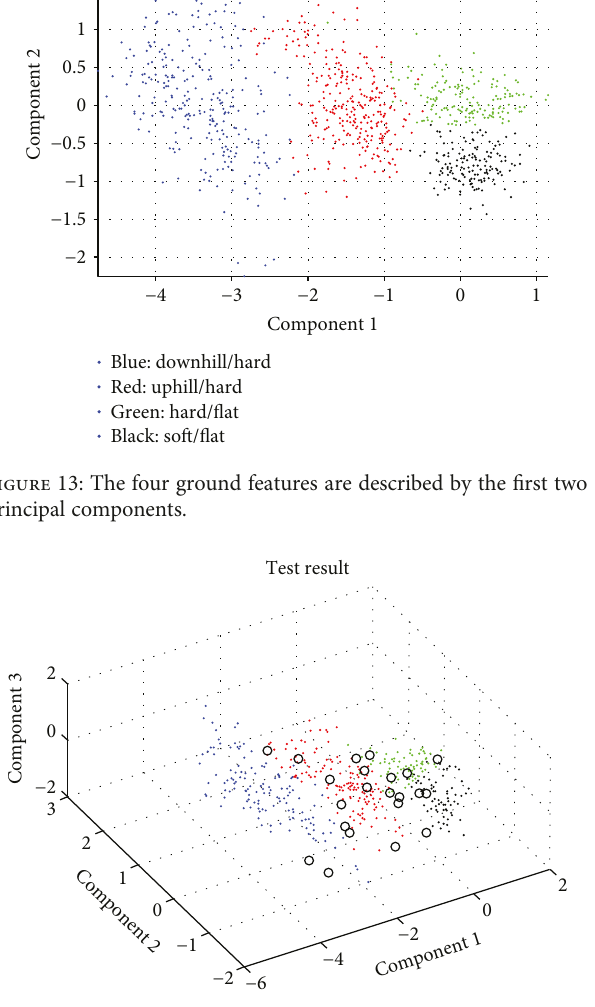
Figure 14: The recognition results for the 4 ground features. Table 3: The recognition rate for the 4 features. D/H U/H H/F